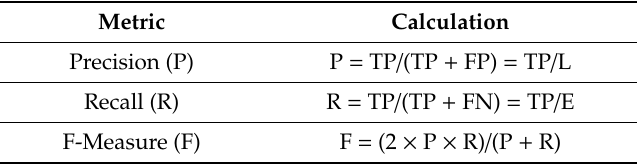
Table 3. Calculations for Precision, Recall and F-Measure (Talburt et al. [23]).